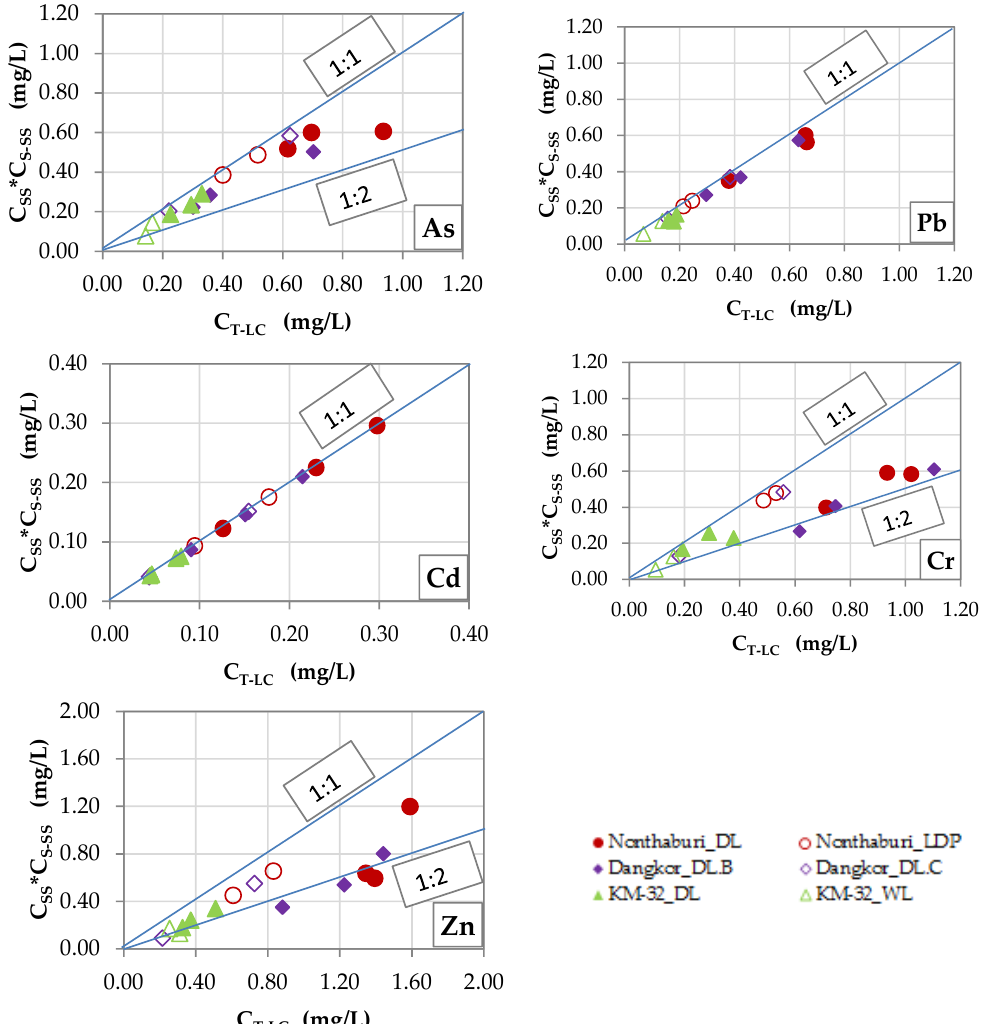
Figure 11. Relationship of HM concentration adsorbed in the SS (C SS *C S-SS ) and total heavy metal concentration of Leachate (C T-LC ).